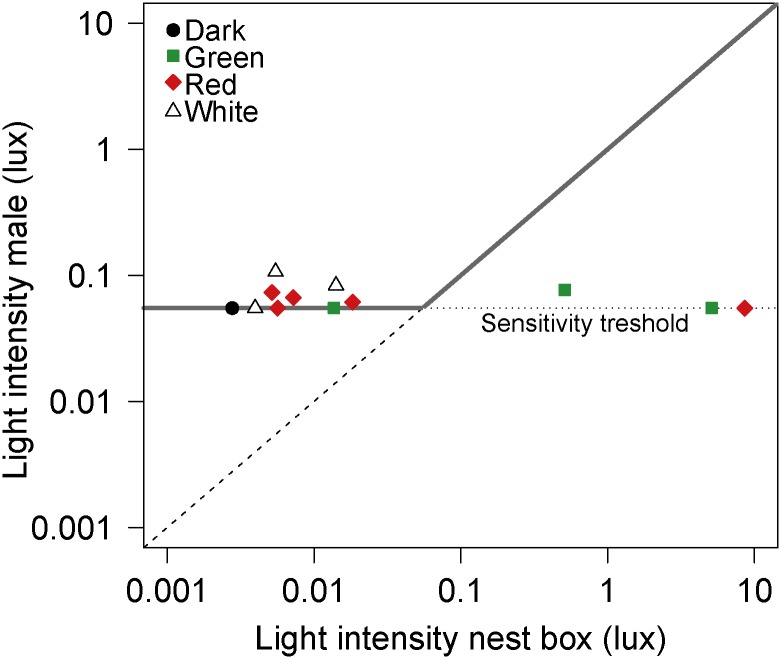
Night-time light exposure of male great tits.Average nocturnal light intensity (lux) that male great tits were exposed to (from two hours after sunset to two hours before sunrise), in relation to the light intensity (lux) measured at the nest box the pair was breeding in. The grey line indicates the expected light exposure if males would roost in the close surroundings of their nest box; this exposure remains level up to 0.055 lux because of the lower sensitivity threshold of the loggers (dotted line) and at higher intensities this is equal to light intensity measured at nest box entrance level (dashed line: light intensity male equals light intensity nest box). Filled black circle is the male with nest in the dark treatment, filled green squares are males with nest in the green treatment, filled red diamonds are males with nest in the red and open triangles are males in the white light treatment. Data from breeding seasons 2014 and 2015; error bars are not shown because standard errors are too small to be visible. Original light logger measurements were corrected to be comparable with the illuminance meter measurements in Fig A in S1 Appendix, see logger calibration data in Fig C in S1 Appendix.